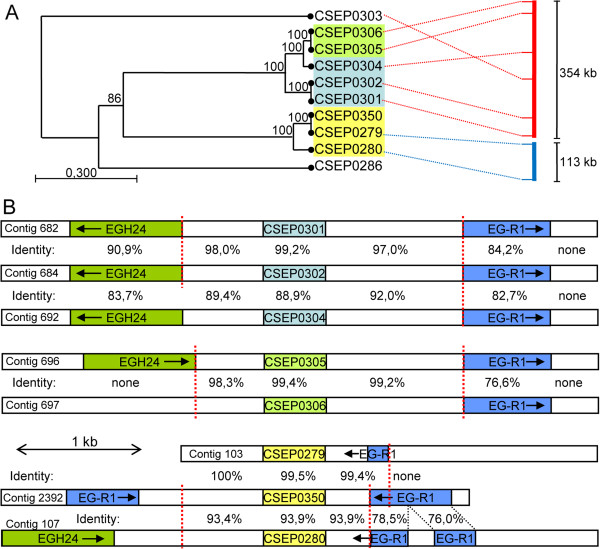
Genome clustering of eight CSEP paralogs from family 7 on two sequence scaffolds. A: Correlations between the phylogenetic relationships based on nucleotide sequences of CSEP paralogs from family 7 and their locations on the genomic sequence scaffolds 005496 (red) and 005502 (blue) indicated with dotted lines. Only the relevant parts of the sequence scaffolds (scale bar) are shown. The colour code of the CSEPs refers to the genomic organization shown in panel B. B: Schematic illustration of the genomic organization (encompassing about 5 kb) of the eight CSEP paralogs with the retro-transposable elements Egh24 and Eg-R1[15,16]. The percentages of nucleotide sequence identity in pairwise comparisons are indicated and abrupt changes in sequence similarity are indicated with vertical dashed lines in red. The colour code of the CSEPs refers to the phylogenetic tree shown in panel A. Scale bars represent lenghts of DNA in base pairs.